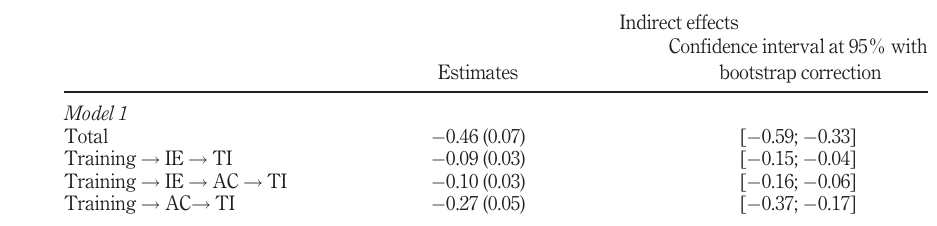
Table 1. Indirect effects of Model 1 ( H4a )